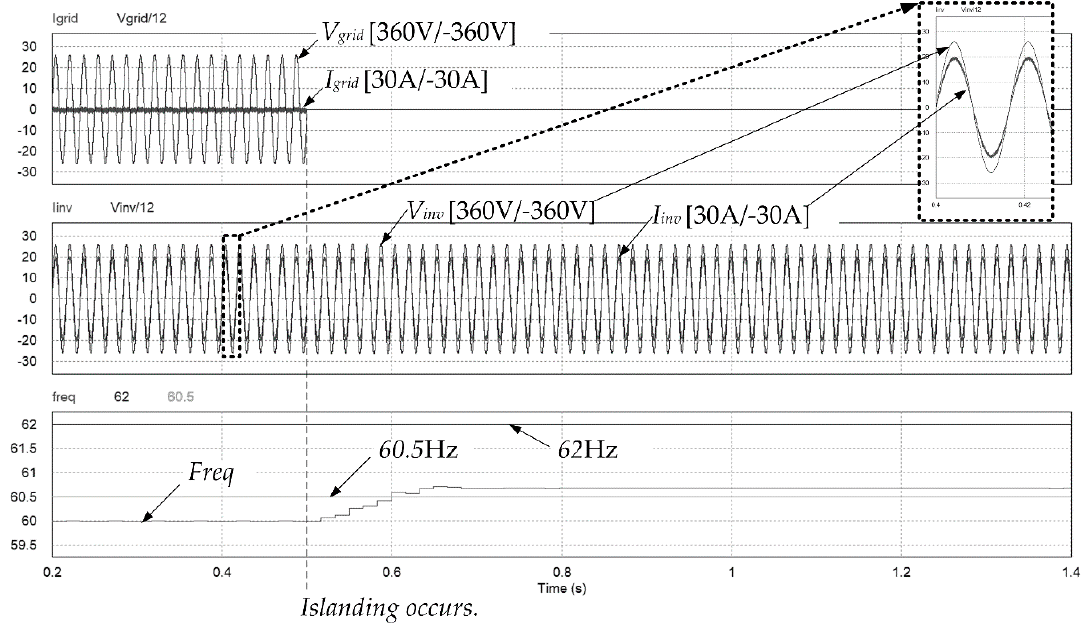
Figure 9. Anti-islanding test results when active frequency drift method with positive feedback is used.